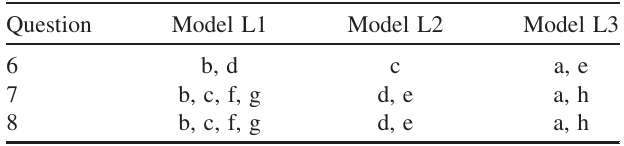
TABLE V. Models and multiple-choice options for